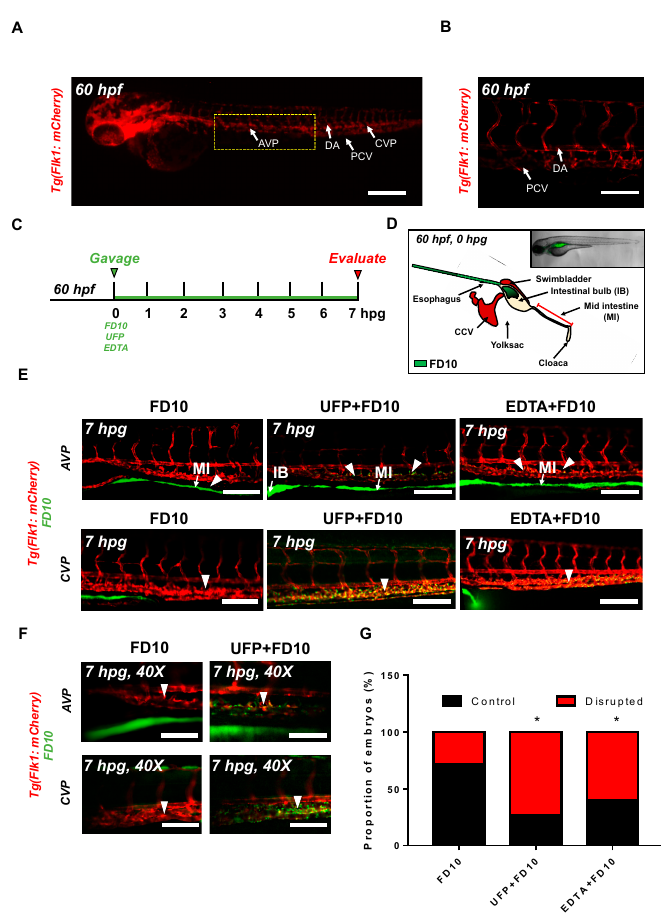
Figure 1. Acute ultrafine particulate matter (UFP) ingestion disrupts intestinal epithelial barrier integrity. Transgenic Tg(flk1: mCherry) zebrafish embryos at 60 hpf were micro-gavaged with FITC-conjugated dextran (FD10, 10 kDa). ( A , B ) Anatomy of endothelial vasculature in the Tg(flk1: mCherry) embryo. DA: dorsal aorta; PCV: posterior caudal vein; AVP: anterior venous capillary plexus; CVP: caudal vein capillary plexus; Scale bar: 32 µ m. ( C ) Experimental design: At 2 dpf, embryos were randomly chosen for micro-gavage with FD10 solution with or without UFP or EDTA at 20 mM. Intestinal barrier integrity and translocation of FD10 to vascular endolumen ( flk1 + ) were evaluated at 7 h post gavage (hpg). ( D ) A schematic representation of micro-gavage in an embryonic gastrointestinal (GI) tract. FD10 solution was micro-gavaged in the intestinal bulb without disrupting the esophagus, swim bladder and yolk sac. ( E ) Representative images of the AVP and CVP at 7 hpg. In FD10 gavaged-controls, FD10 remained only in the intestinal bulb and mid-intestine. In contrast, co-gavaging FD10 with UFP or ethylenediaminetetraacetic acid (EDTA) accumulated FD10 in the AVP and CVP (white arrow heads). Scale bar: 20 µ m. ( F ) Magnified view of the AVP and CVP. Scale bar: 20 µ m. ( G ) Percentage of embryos exhibiting endoluminal FD10 fluorescence ( * p < 0.05 vs. FD10, n = 10 per group).